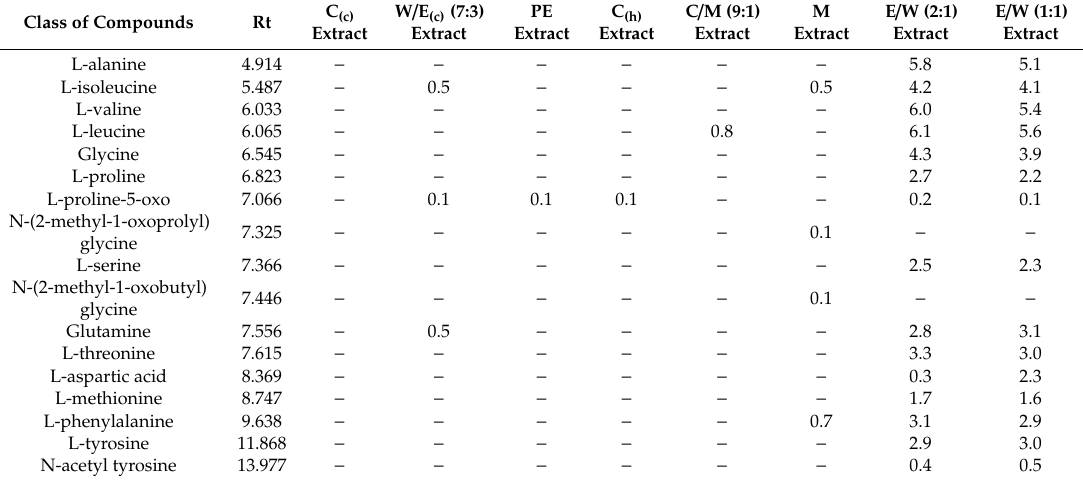
Table 3. Amino acids composition (% weight) identified in the bioglea